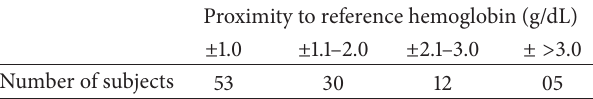
Table 2: Proximity of the test results to the reference method (cyanmethemoglobin